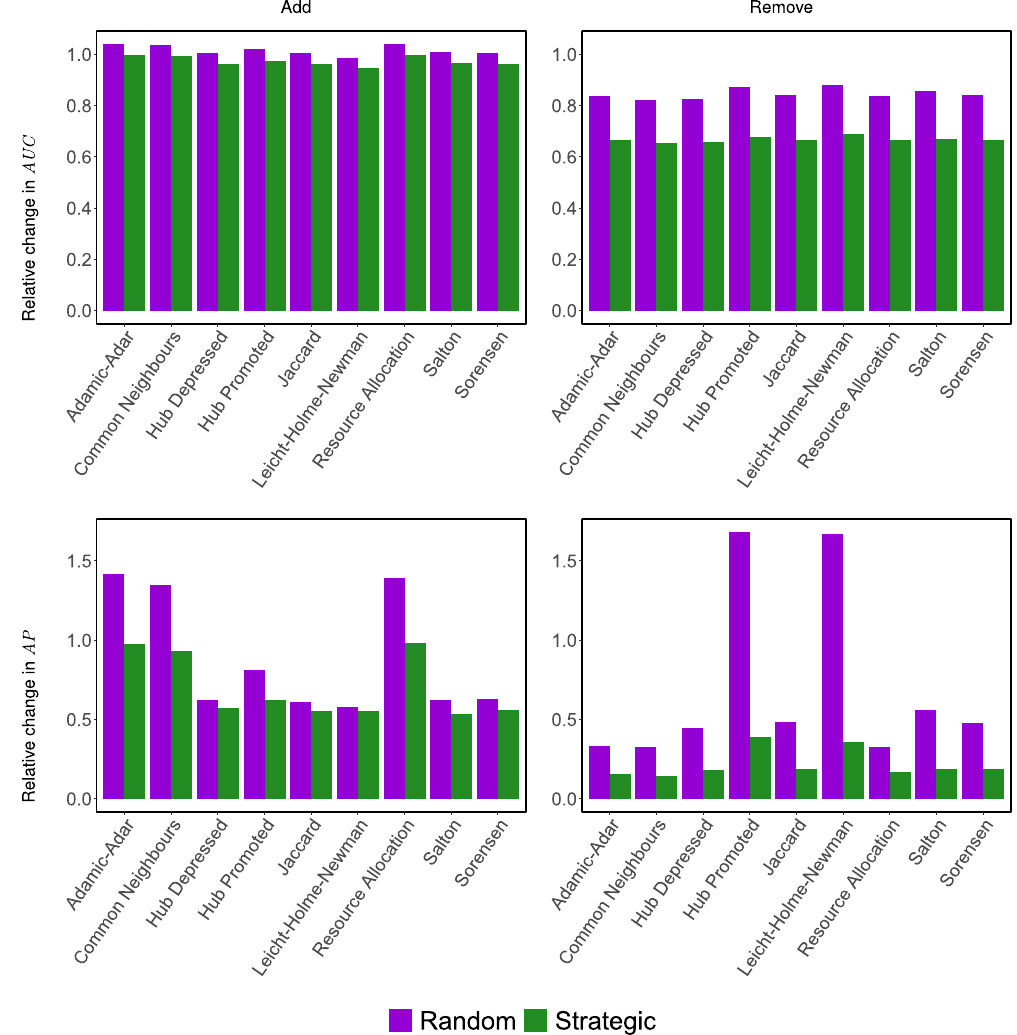
Figure 5. Comparing the error vs. attack tolerance of different similarity indices, by comparing the impact of modifying links that are chosen randomly against those that are chosen strategically by one of our heuristics. Specifically, for each network outlined in Section S7.1, we randomly select 10 evaders that have at least 9 connections each (this ensures that any such evader will not become entirely disconnected when running CTR). For each evader, we randomly select five instances of H , each containing 3 edges selected randomly from the evader’s connections. For each such H , we run experiments with a budget b = 5. This budget is then spent either randomly, or by one of our heuristics. The results depicted in the figure are averaged over all considered networks (for randomly generated networks, the experiment is repeated over 50 instances). We disregard any H for which the performance metric is below 0.001, and assume the edges therein to be hidden